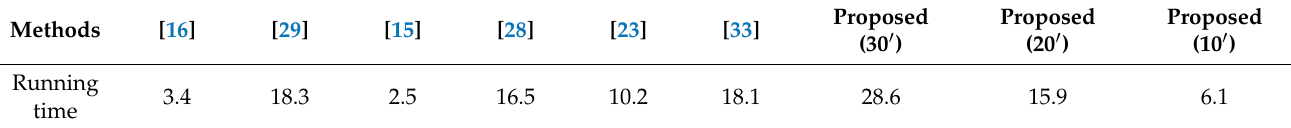
Table 5. Running time of different methods (seconds).